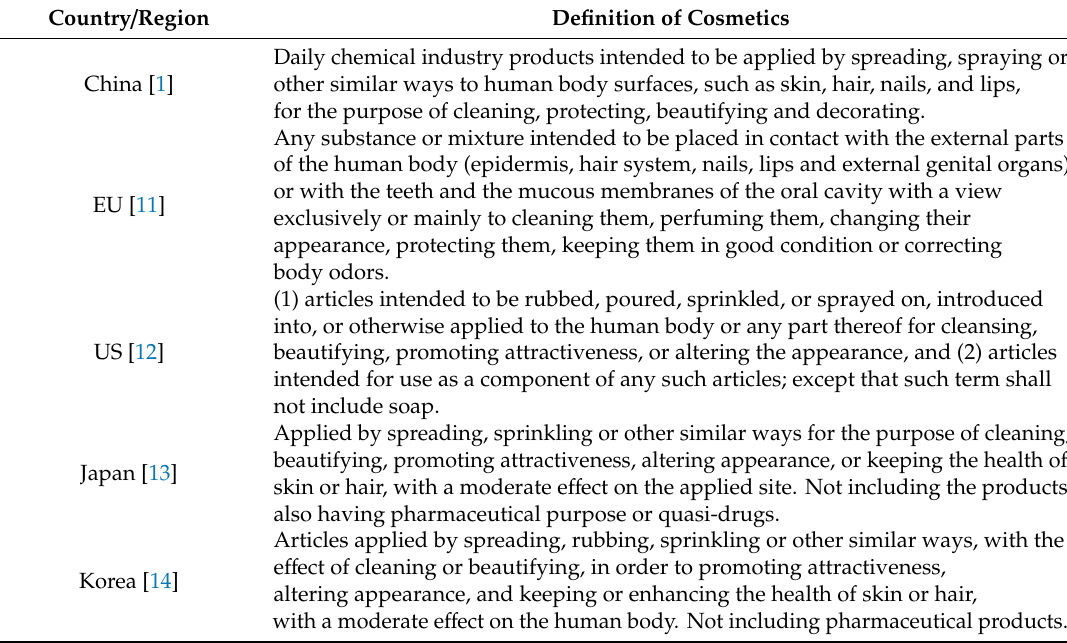
Table 2. A comparison of the definitions of